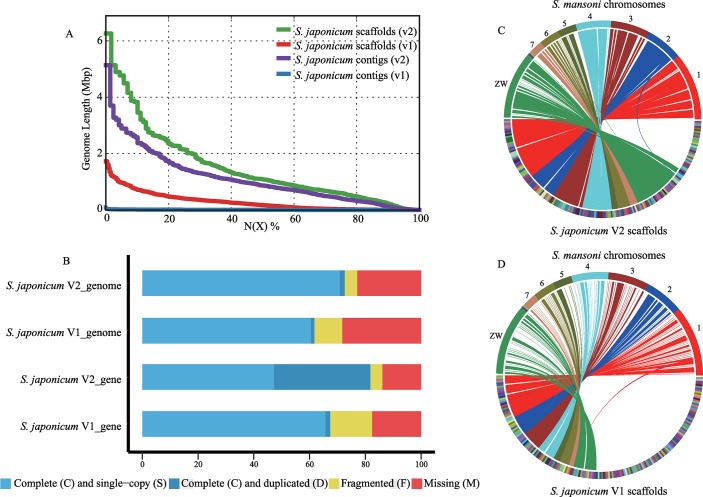
Genome assembly of Schistosoma japonicum.(A) Comparison of contiguity between the two versions of S. japonicum genome assembly. N(x)% graph shows the contig and scaffold sizes (y-axis), where x% of the genome assembly consists of contigs and scaffolds of at least that size. (B) comparison between two version of S. japonicum genome assembly, showing the portions of the genomes that are complete (blue), fragmented (yellow) or missing (red), as determined by benchmarking universal single-copy orthologs (BUSCO) analysis with metazoan_odb9 database. (C) Circle plot of synteny between the second version of S. japonicum genome and S. mansoni genome V7 made using SyMAP. It shows a high degree of synteny, with many long S. japonicum scaffolds covering significant portions of S. mansoni chromosome. (D) Circle plot of synteny between the first version of S. japonicum genome and S. mansoni genome. V1 indicated conventional capillary sequenced genome and V2 indicated our improved genome.